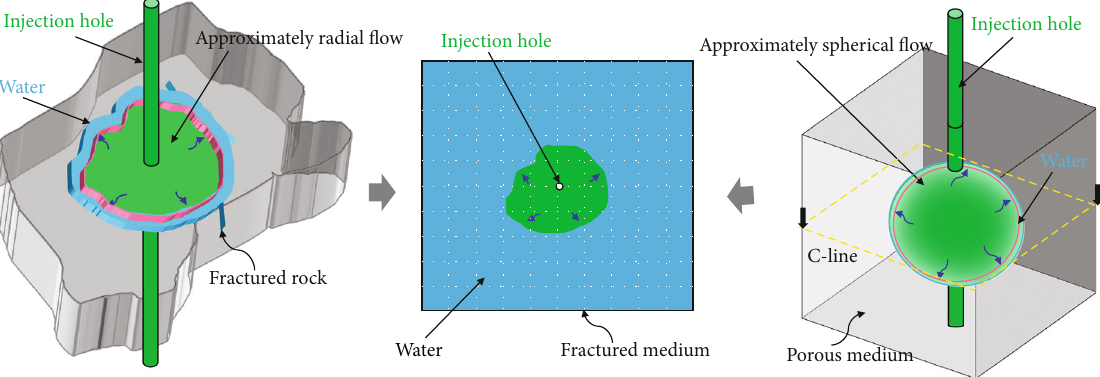
Figure 4: Schematic diagram of rock